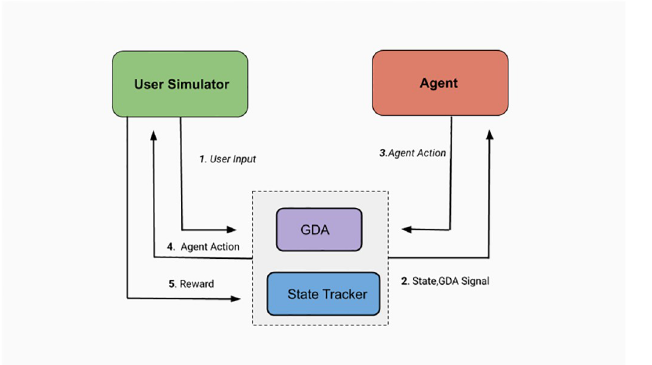
Fig 7. Training flow of the proposed RL based